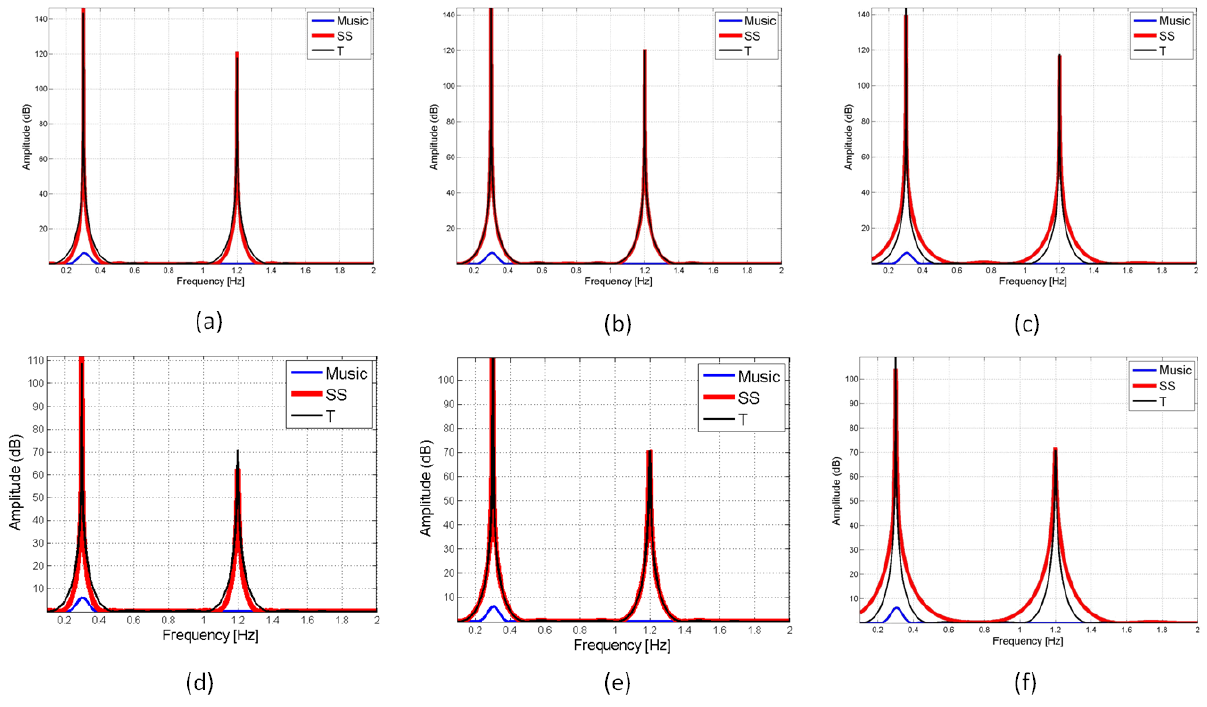
Figure 3: Synthetic data with acquisition time equal to 10 s . Pseudospectrum comparison between SS (red line) and Toeplitz (black line) methods by varying the number of samples and the decorrelation index: (a) L = 270 , M d = 53 , (b) L = 270 ,